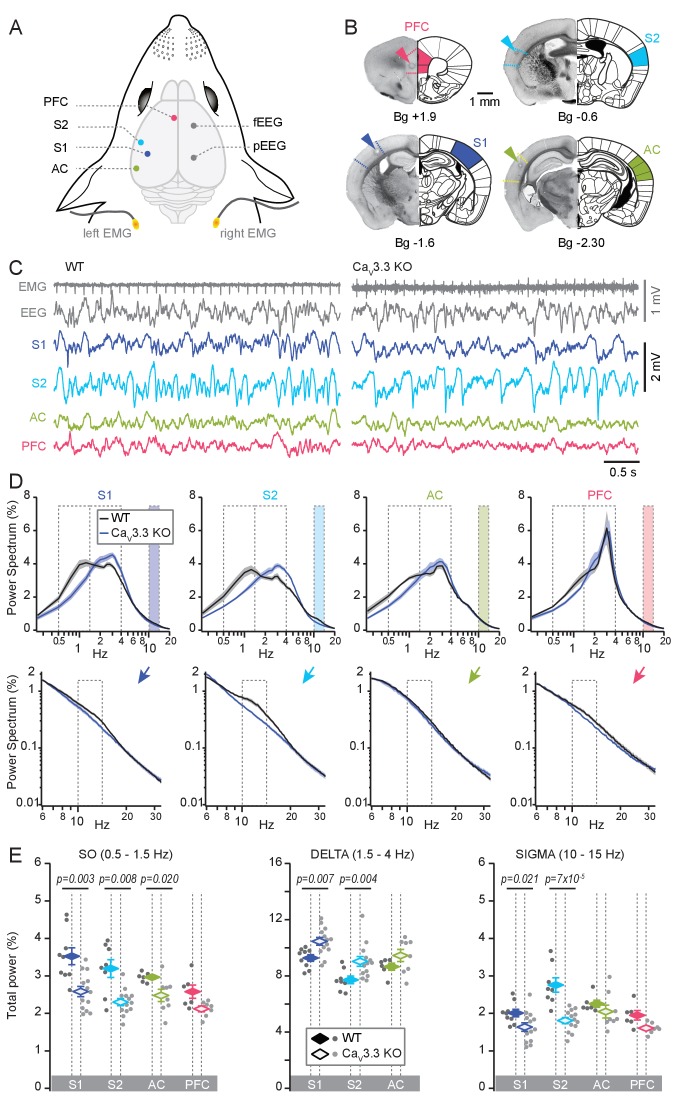
Cortical-area specific NREMS features depend on CaV3.3 Ca2+ channels.(A) Schematic illustrating implantation sites for LFP, EEG (fEEG and pEEG; frontal and parietal EEG) and EMG electrodes. S1, S2; primary and secondary somatosensory areas; AC, auditory cortex; PFC, medial prefrontal cortex. (B) Histological sections of representative cases confirming the location of the recording sites. Arrowheads mark site of lesion caused by electrocoagulation. Anteroposterior stereotaxic coordinates are given relative to Bregma (Bg). (C) Representative raw traces of NREMS for WT (left) and CaV3.3 KO (right) animals, showing (from top to bottom) the EMG, EEG and LFP signals for S1, S2, AC and PFC (infra-/prelimbic area). The heart beat is visible on the EMG trace. (D) Power spectra corresponding to the LFP recordings, plotted in a linear-log plot to emphasize the three frequency bands of interest: the SO (0.5–1.5 Hz), the delta (1.5–4 Hz) and the sigma band (10–15 Hz). The sigma band is colored and shown in expanded log-log plots at the bottom. Normalized mean ±S.E.M. values of power spectral density are shown for S1, S2, AC and PFC for both genotypes (WT: n = 9 for S1, n = 8 for S2, n = 6 for AC, n = 6 for PFC; CaV3.3 KO: n = 13 for S1, n = 13 for S2, n = 8 for AC, n = 7 for PFC). (E) Mean total power for the three frequency bands across S1, S2, AC and PFC, with values for individual animals shown in points (dark gray for WT, light gray for CaV3.3 KO animals), and mean values ± S.E.M. in color diamonds. Statistical significance was tested for each area separately, comparing WT and CaV3.3 KO. Mann-Whitney non-parametric test for WT vs CaV3.3 KO, for S1, p=0.003 for the SO, p=0.007 for delta, p=0.021 for sigma; for S2, p=0.008 for the SO, p=0.005 for delta, p=6.9×10−5 for sigma; for AC, p=0.02 for the SO, p>0.05 for delta and sigma; for PFC, all p-values>0.05. Bonferroni-corrected α-threshold for the three frequency bands was 0.017.10.7554/eLife.39111.009Figure 3—source data 1.Numerical data values and statistics underlying Figure 3.